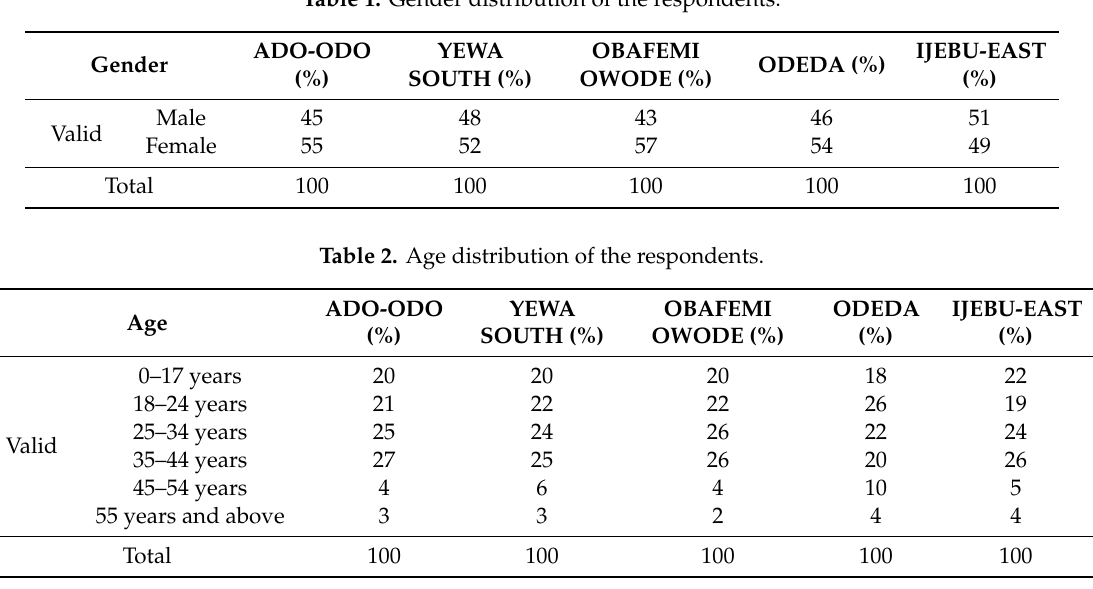
Table 1. Gender distribution of the respondents.